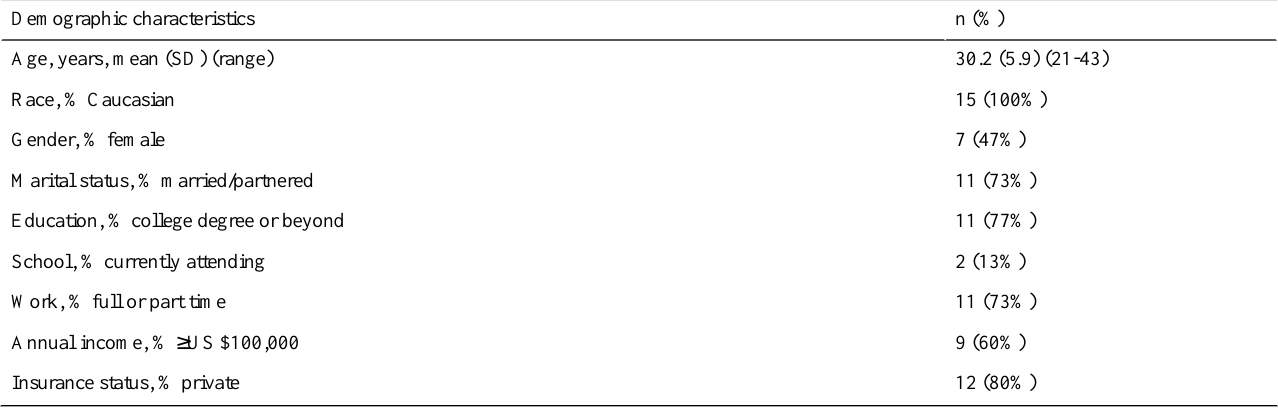
Table 1. Participant characteristics (n=15) a